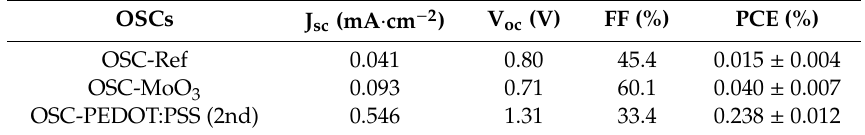
Table 1. Photovoltaic performances of OSCs employing water-processed P3HTN:PEG-C 60 thin films.